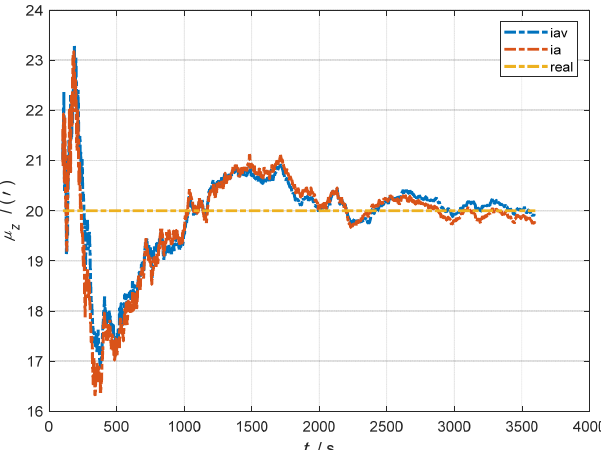
Figure 20. The curves of µ y in the cases of the initial misalignment angles [ 5 ◦ 5 ◦ 20 ◦ ] T .